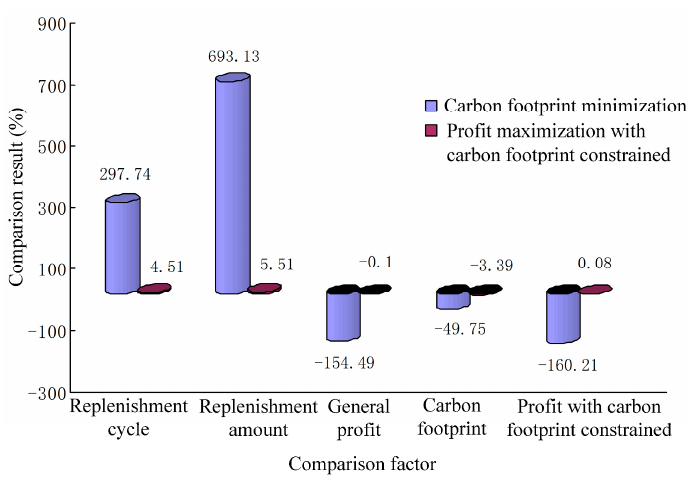
Figure 2. Comparison between the carbon footprint minimization and the profit maximization with carbon footprint constraint in different factors.